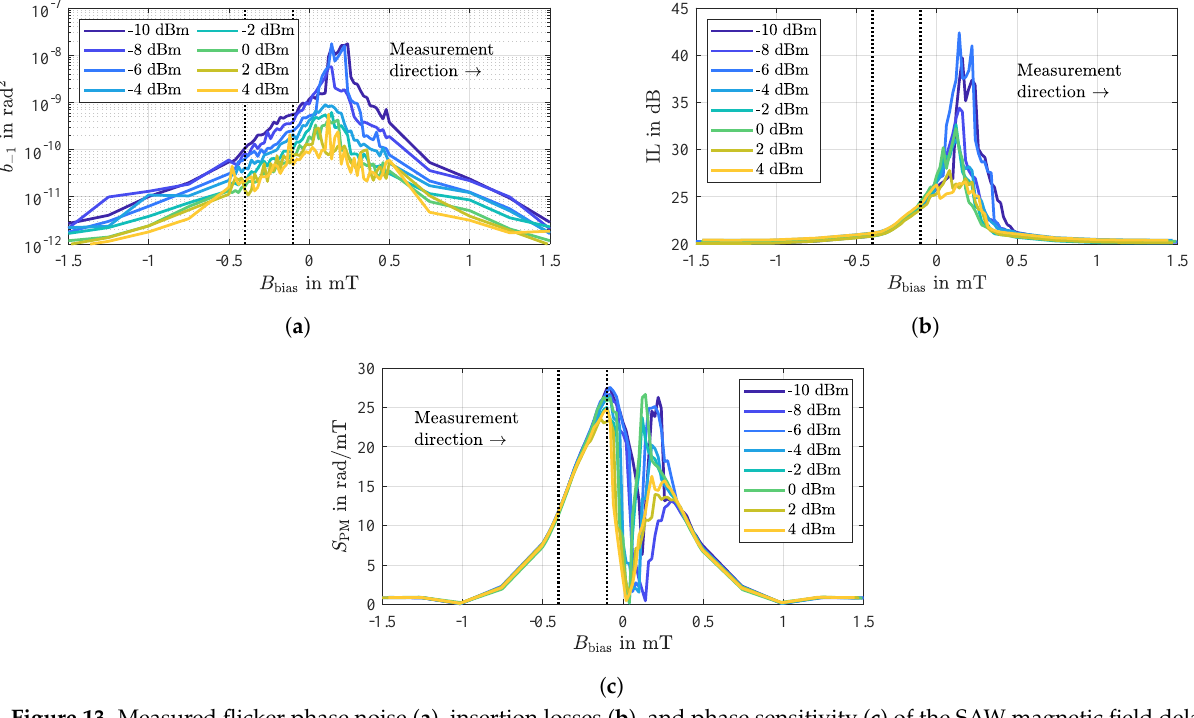
Figure 13. Measured flicker phase noise ( a ), insertion losses ( b ), and phase sensitivity ( c ) of the SAW magnetic field delay line sensor as a function of the ambient magnetic bias flux density B bias and for various input power levels P 0 . The sensor is operated preferably in a certain range (marked by dotted lines, here approximately between − 0.4mT and − 0.1mT) where the insertion losses and thus the flicker phase noise are comparatively low but the sensitivity is still